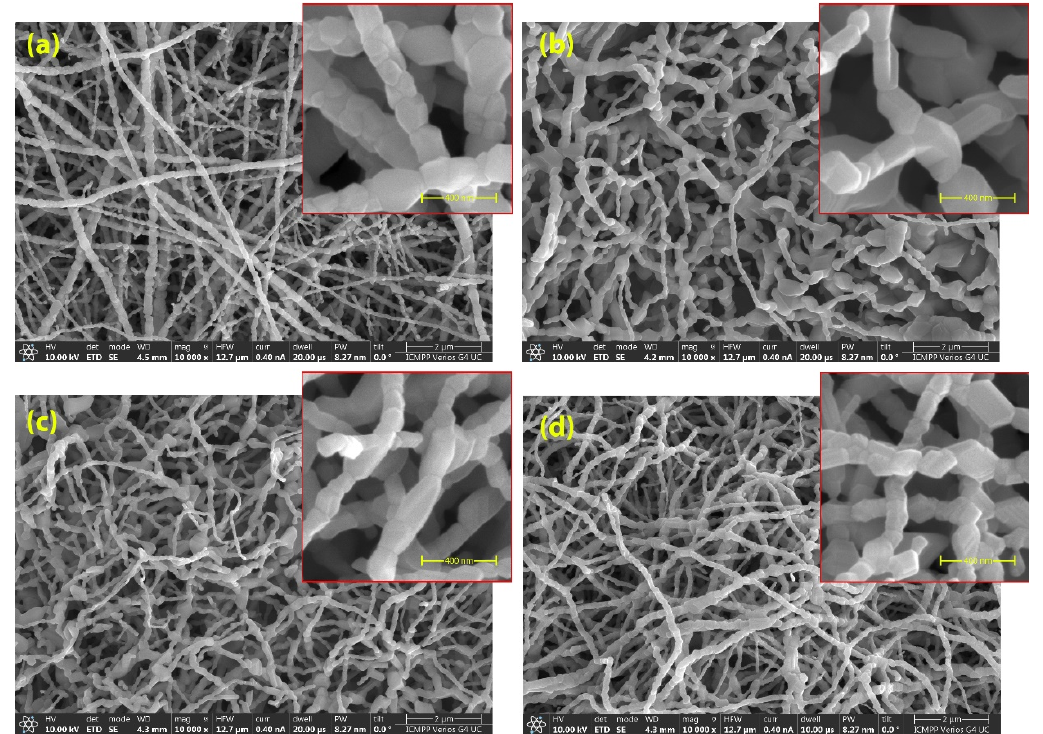
Figure 2. SEM images for pure TiO 2 ( a ) and 0.5% ( b ), 1% ( c ), and 2% ( d ) Cu-doped TiO 2